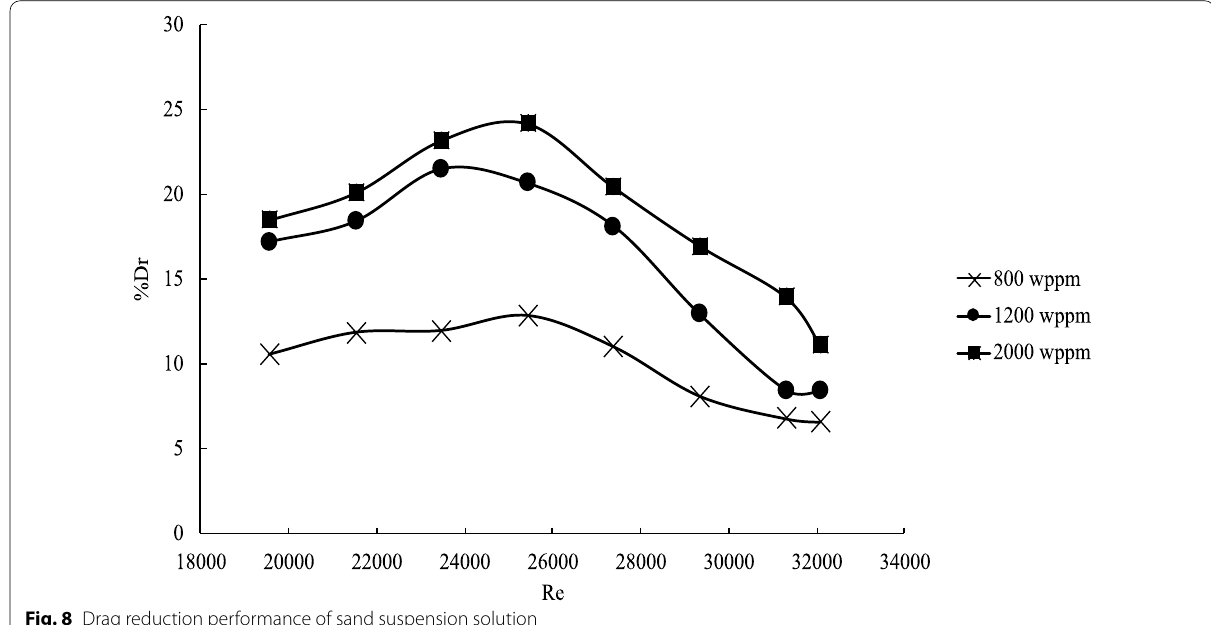
Fig. 8 Drag reduction performance of sand suspension solution